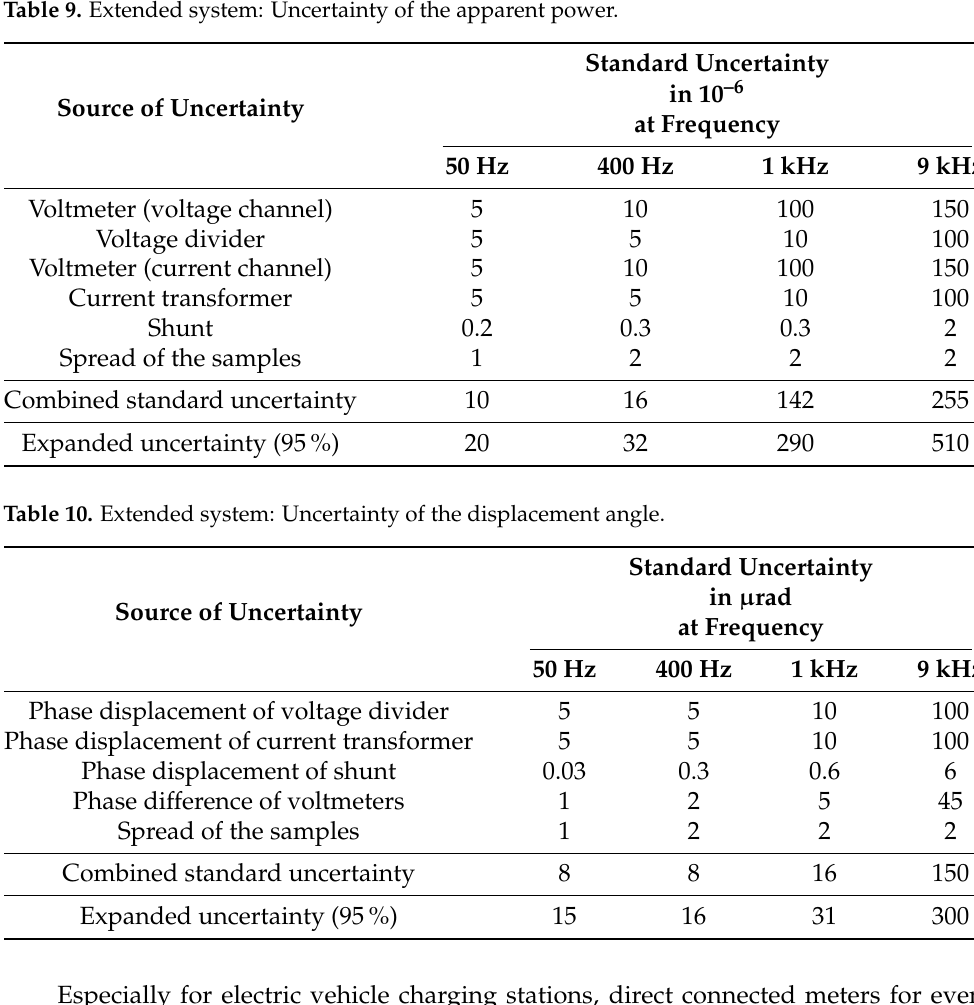
Table 9. Extended system: Uncertainty of the apparent power.